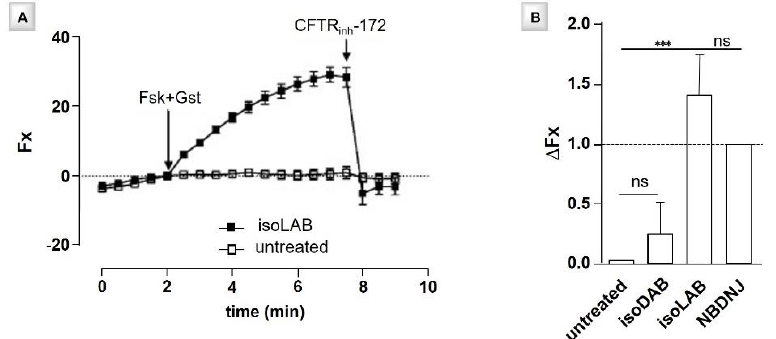
Figure 11. Functional evaluation of F508del-CFTR activity by single-cell fluorescence imaging assay in CF-KM4 cells treated with isoLAB (100 µ M, 2 h). ( A ) Time courses obtained with untreated cells or with cells treated with isoLAB in the presence of forskoline / genistein. ( B ) Histograms summarizing the results collected from separate experiments. *** p < 0.001; ns, not significant. This figure is reprinted from [136], with permission from Elsevier.